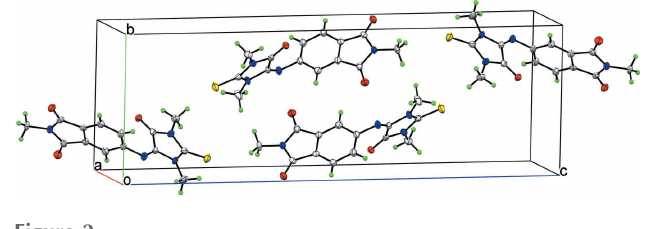
Figure 2 The crystal packing of 1 , viewed along the a -axis